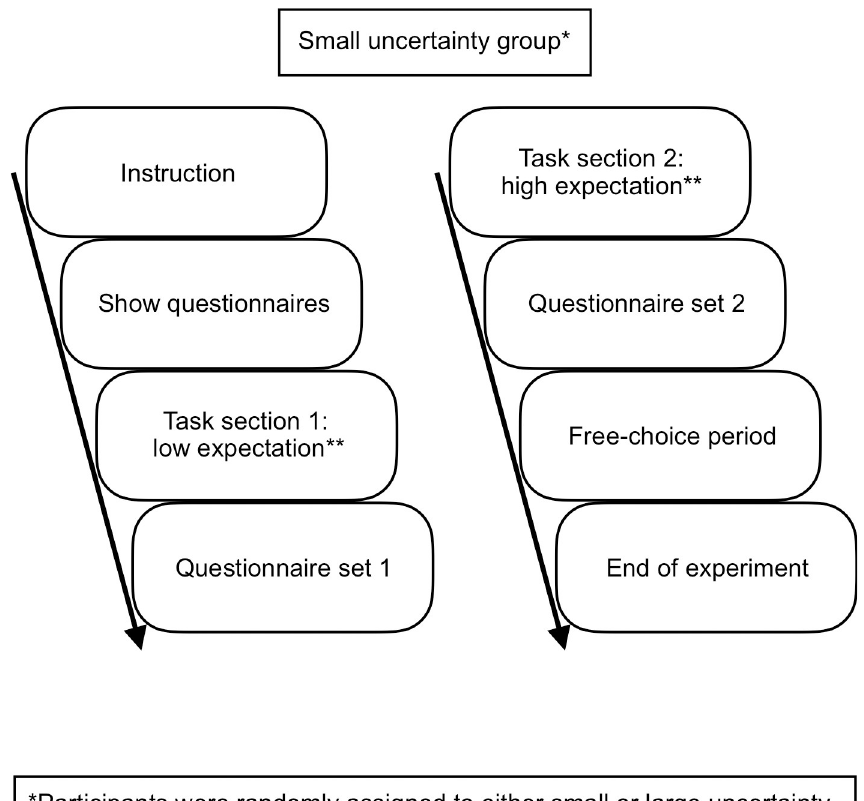
Fig 5. Overview of experimental procedures. Uncertainty was controlled between groups, whereas expectation was controlled within each